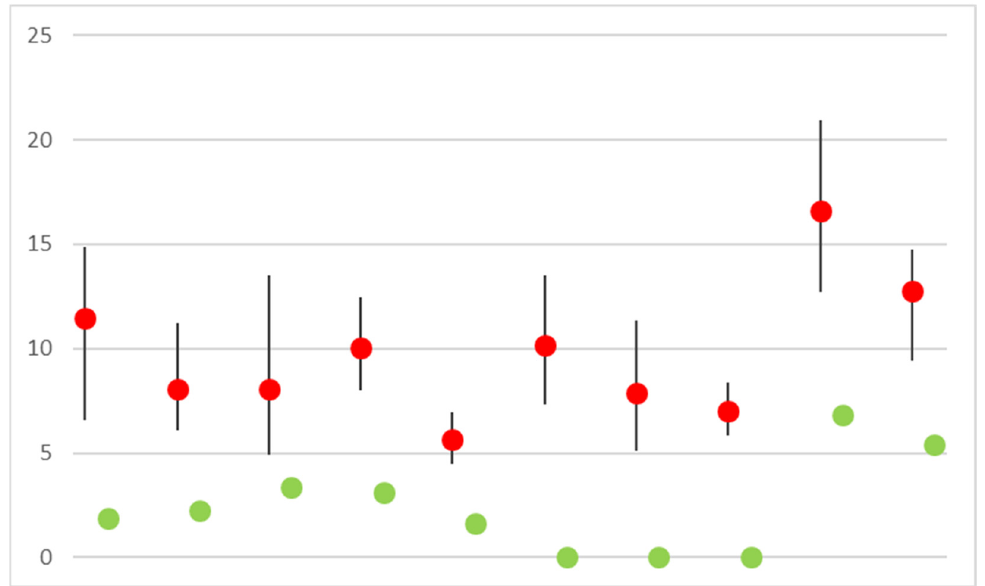
Figure 3. Formaldehyde concentrations (in µg/m 3 ) in the classrooms (minimum—arithmetic mean— maximum, in red) and in front of the school (one sampling point per school, in green).